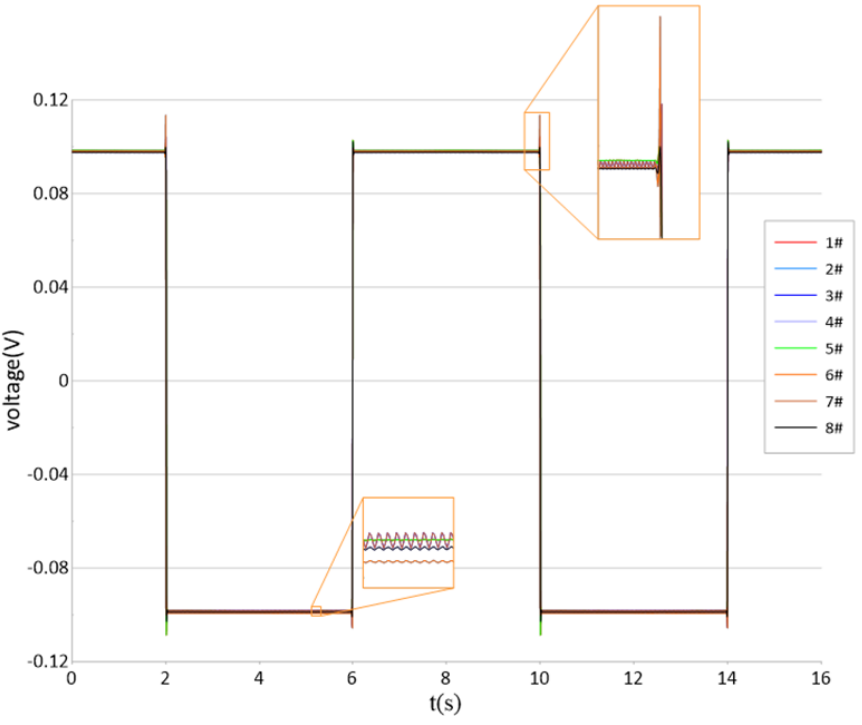
Figure 19. Sampled waveform for each channel for the square wave.